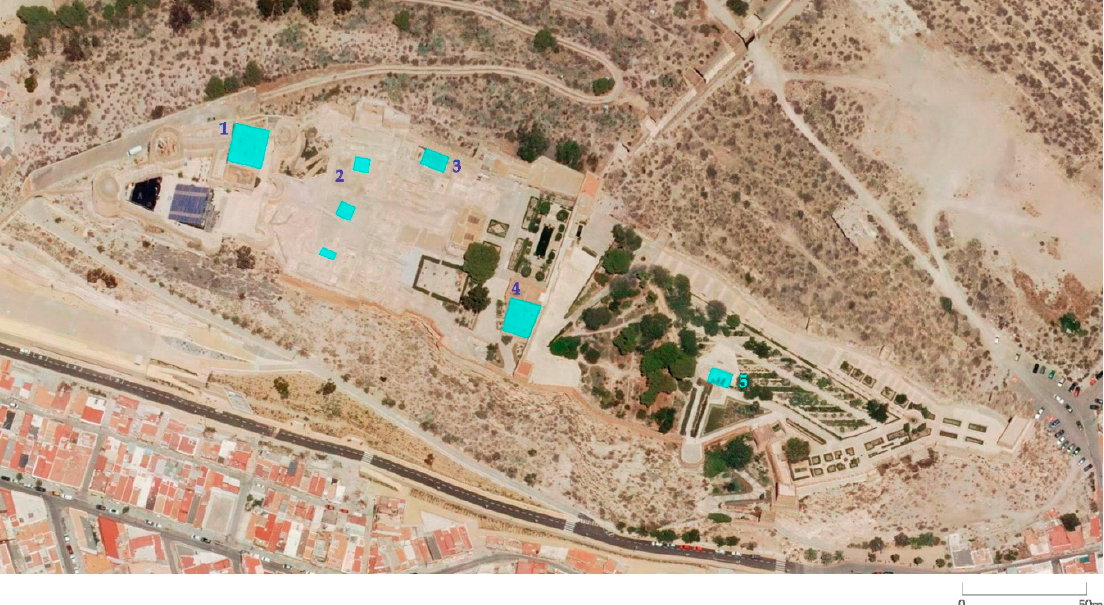
Figure 2. Hypothesis on the development of the Alhambra and its surroundings at the time of maximum expansion during the second half of the fourteenth century. Created by authors.